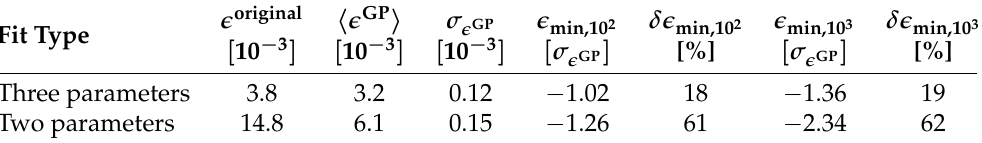
Table 1. Parameters of the MSE distribution for the GP and the original fits, together with (cid:101) min, i and δ (cid:101) min, i for i = 10 2 ,10 3 to show the evolution of the MSE for iterative application of GP.